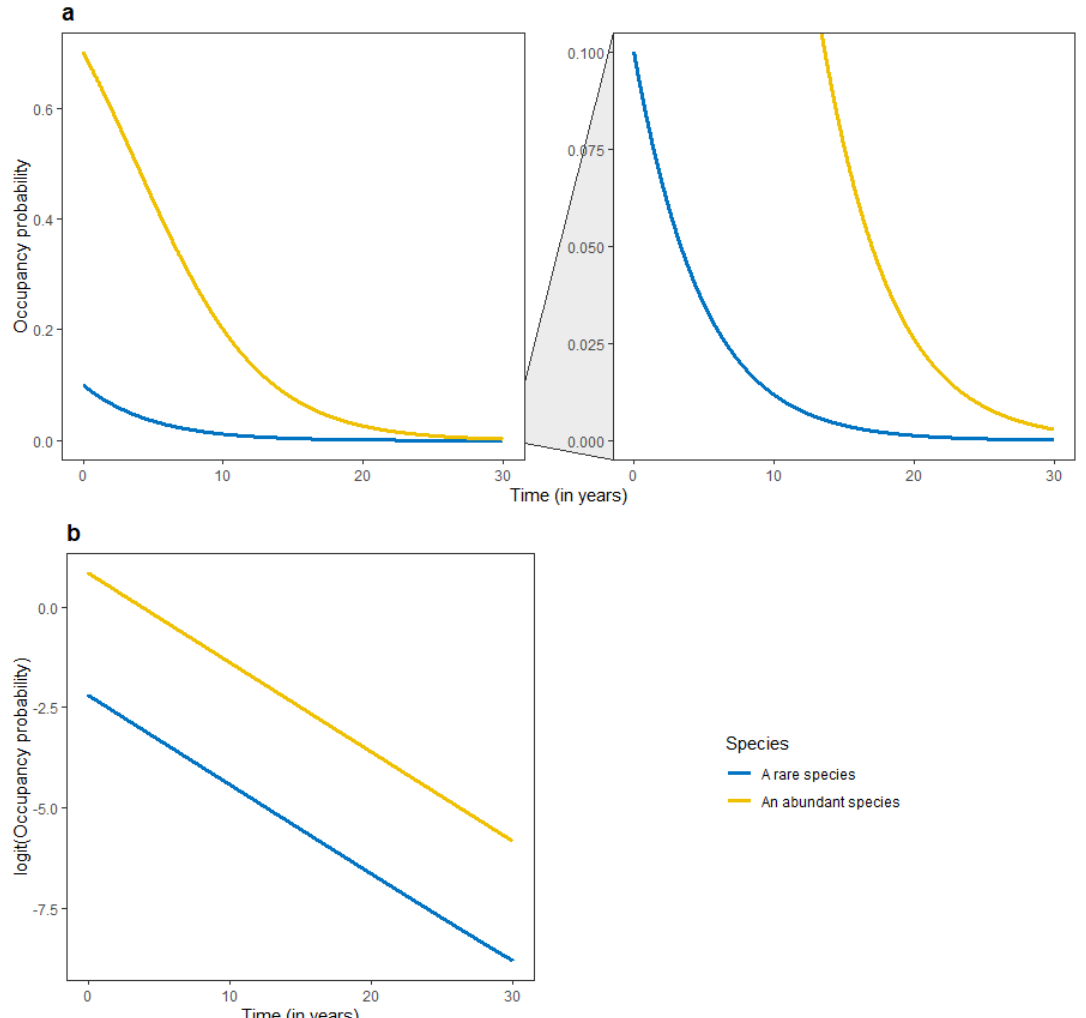
Figure S3: Representation of a geometric decline over time. (a) Occupancy probability, measured as the proportion of grid cell occupied by a species on a given area, against time, for two species declining at a growth rate of 0.8, as in figure S2. Zooming on a part on the bottom of the y-axis, we can see that both species decline with the same rate, but since one is rare and the other is common, variations in number of individuals is much larger for the common species. (b) represents the same dynamics as in a, but when applying the transformation logit(x) to the occupancy probability. On the logit scale we can see that declines are linear and identical (same slopes) between both species, and can easily be estimated with a linear